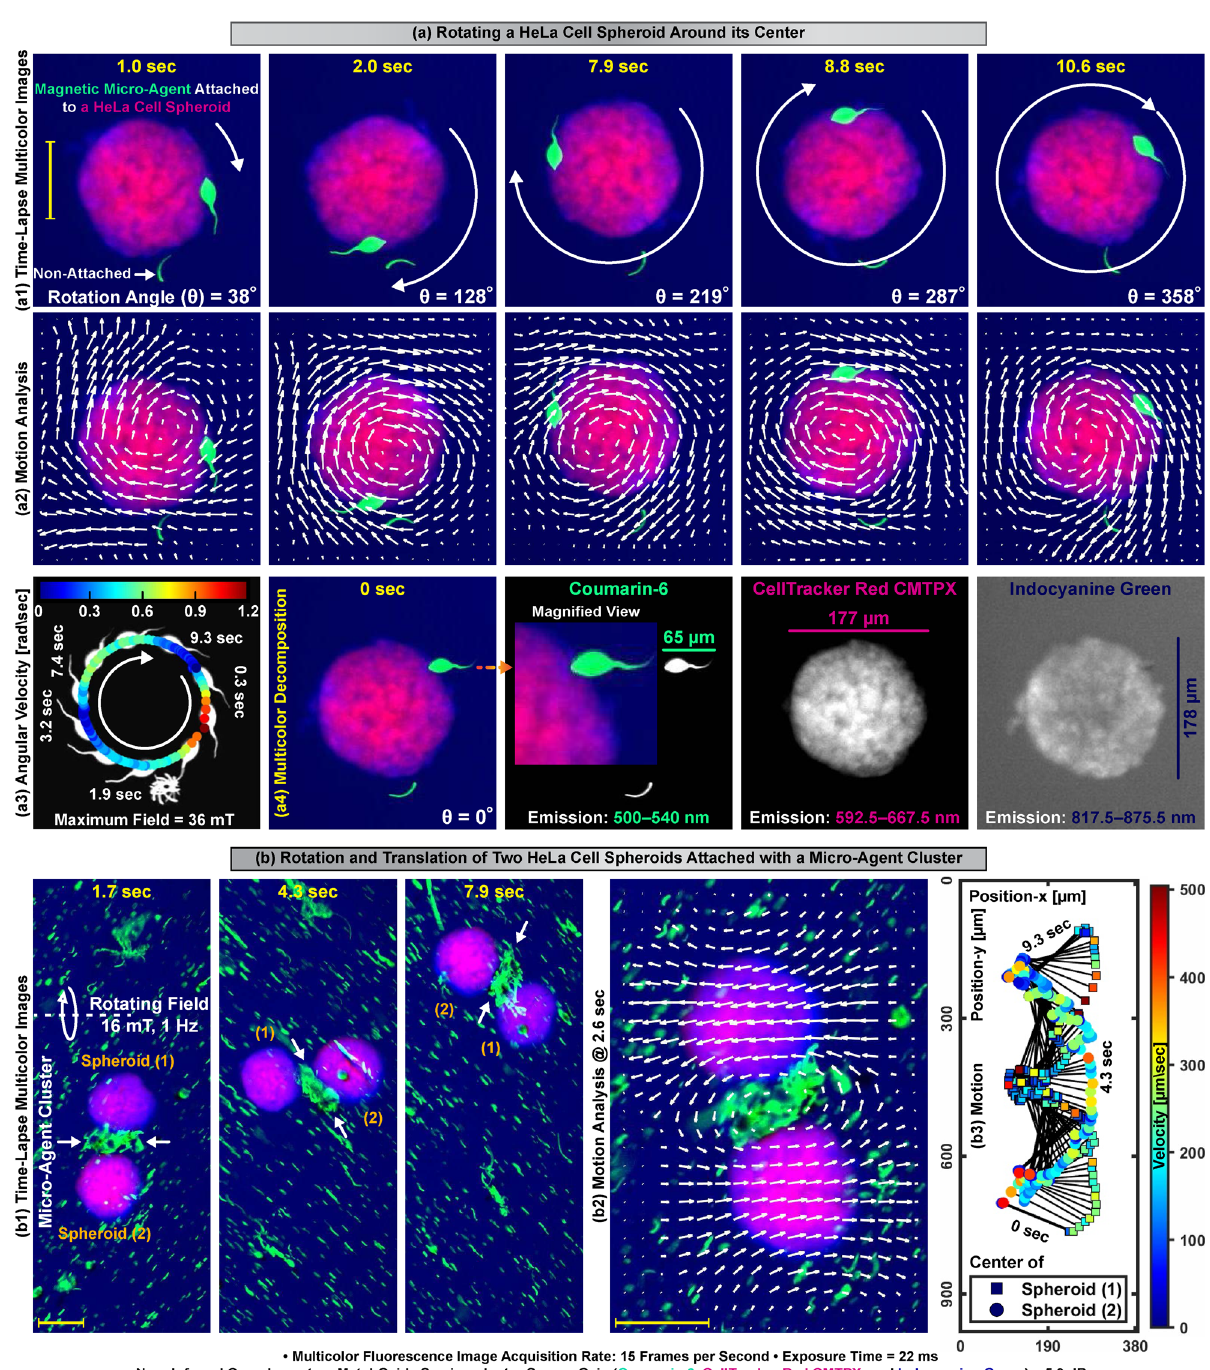
Figure 5. Rotation and translation of HeLa cell spheroids with micro-agents attachment in a reservoir filled with culturing medium and indocyanine green. ( a1 , b1 ) Actuation of the spheroids with single and cluster of micro-agent, respectively. ( a2 , b2 ) Vector fields overlaid on the time-lapse multicolor images show the rotational motion of the spheroids analyzed using Lucas-Kanade optical flow. ( a3 , b3 ) Motion profile and velocity information of the spheroids. ( a4 ) Spectral image decomposition of the multicolor image at time zero. Scale bar 100 µ m. Please refer to the accompanying video (Part